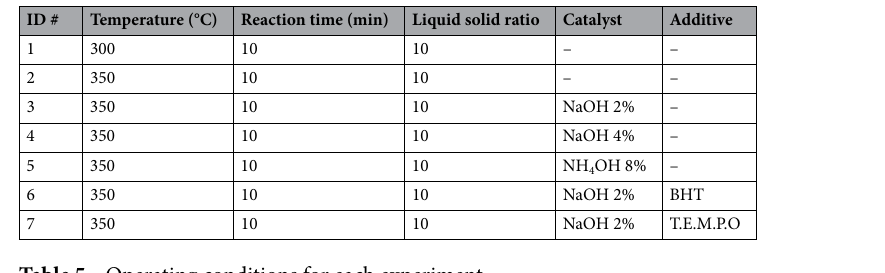
Table 5. Operating conditions for each experiment.